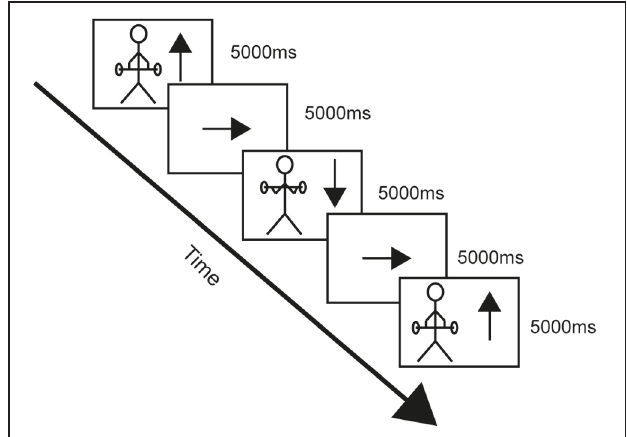
FIGURE 2 | A schematic drawing of one cycle of the imagined concentric and eccentric